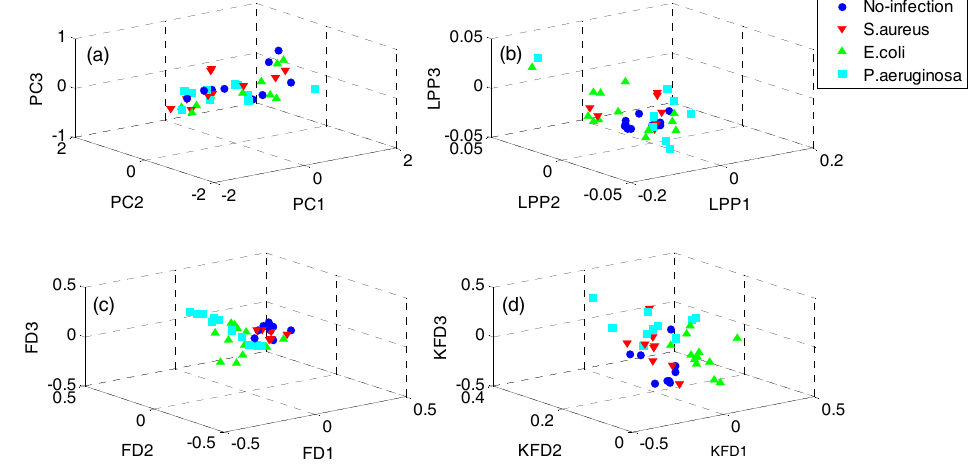
Figure 4. ( a ) Score plots of principal component analysis (PCA), ( b ) locality preserving projections (LPP), ( c ) Fisher discriminant analysis (FDA) and ( d ) kernels Fisher discriminant analysis (KFDA).